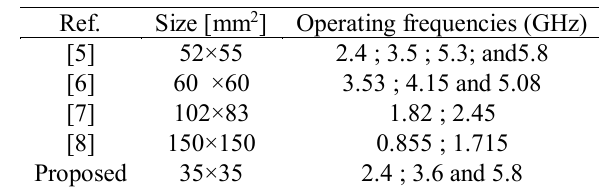
Table 2: Performance comparison of the proposed antenna with other reported antennas.